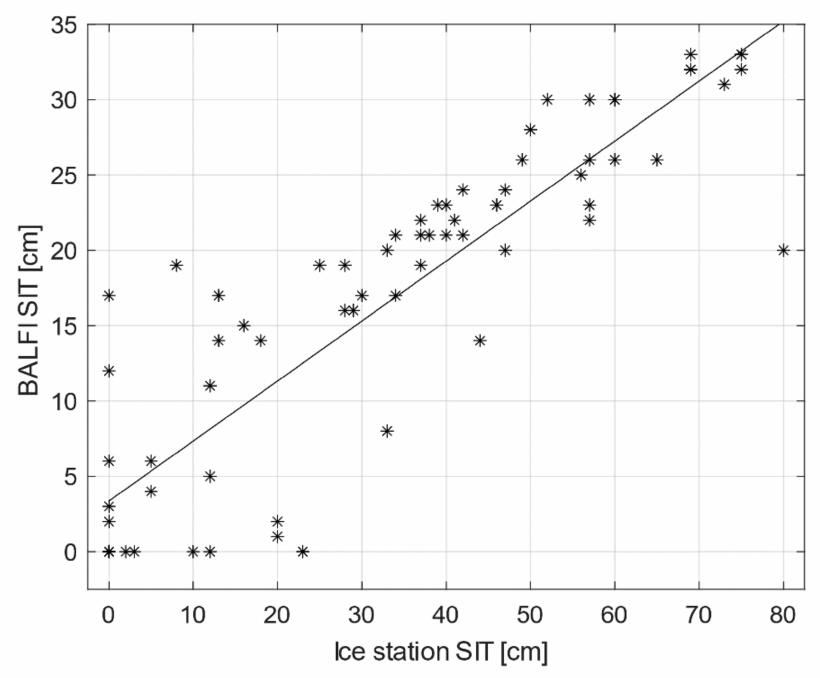
Figure 13. Scatterplot between sea ice thickness data from seven FIS coastal ice stations in the Bay of Bothnia and the BALFI data at the station locations. Linear regression model between the datasets (see Equation (4)) is shown with the black